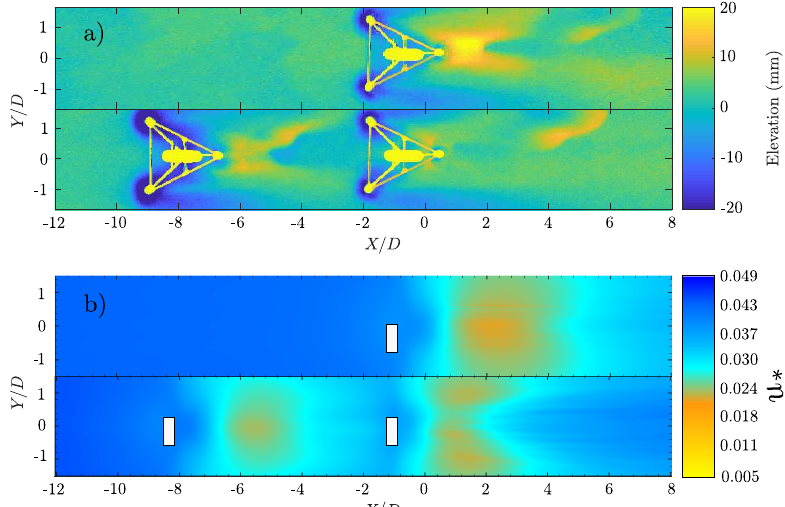
Figure 9. ( a ) Experimental elevation after experiments and ( b ) average shear stress calculated from the DES-BEM model. The DES-BEM model results show a similar low-shear zone after the turbines, which is coincident with experimental